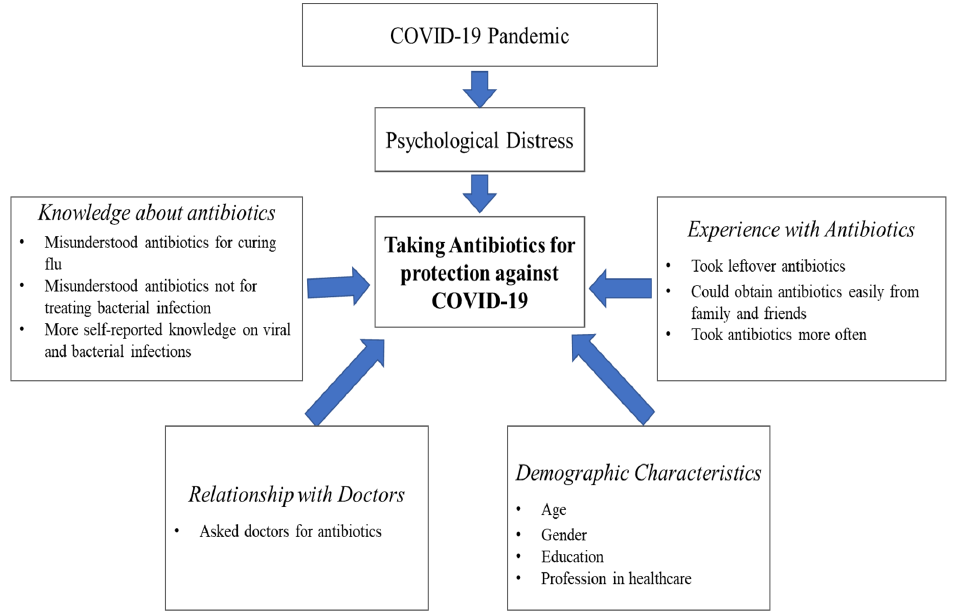
Figure 1. An integrative framework explaining self-medication with antibiotics for prevention against COVID-19.